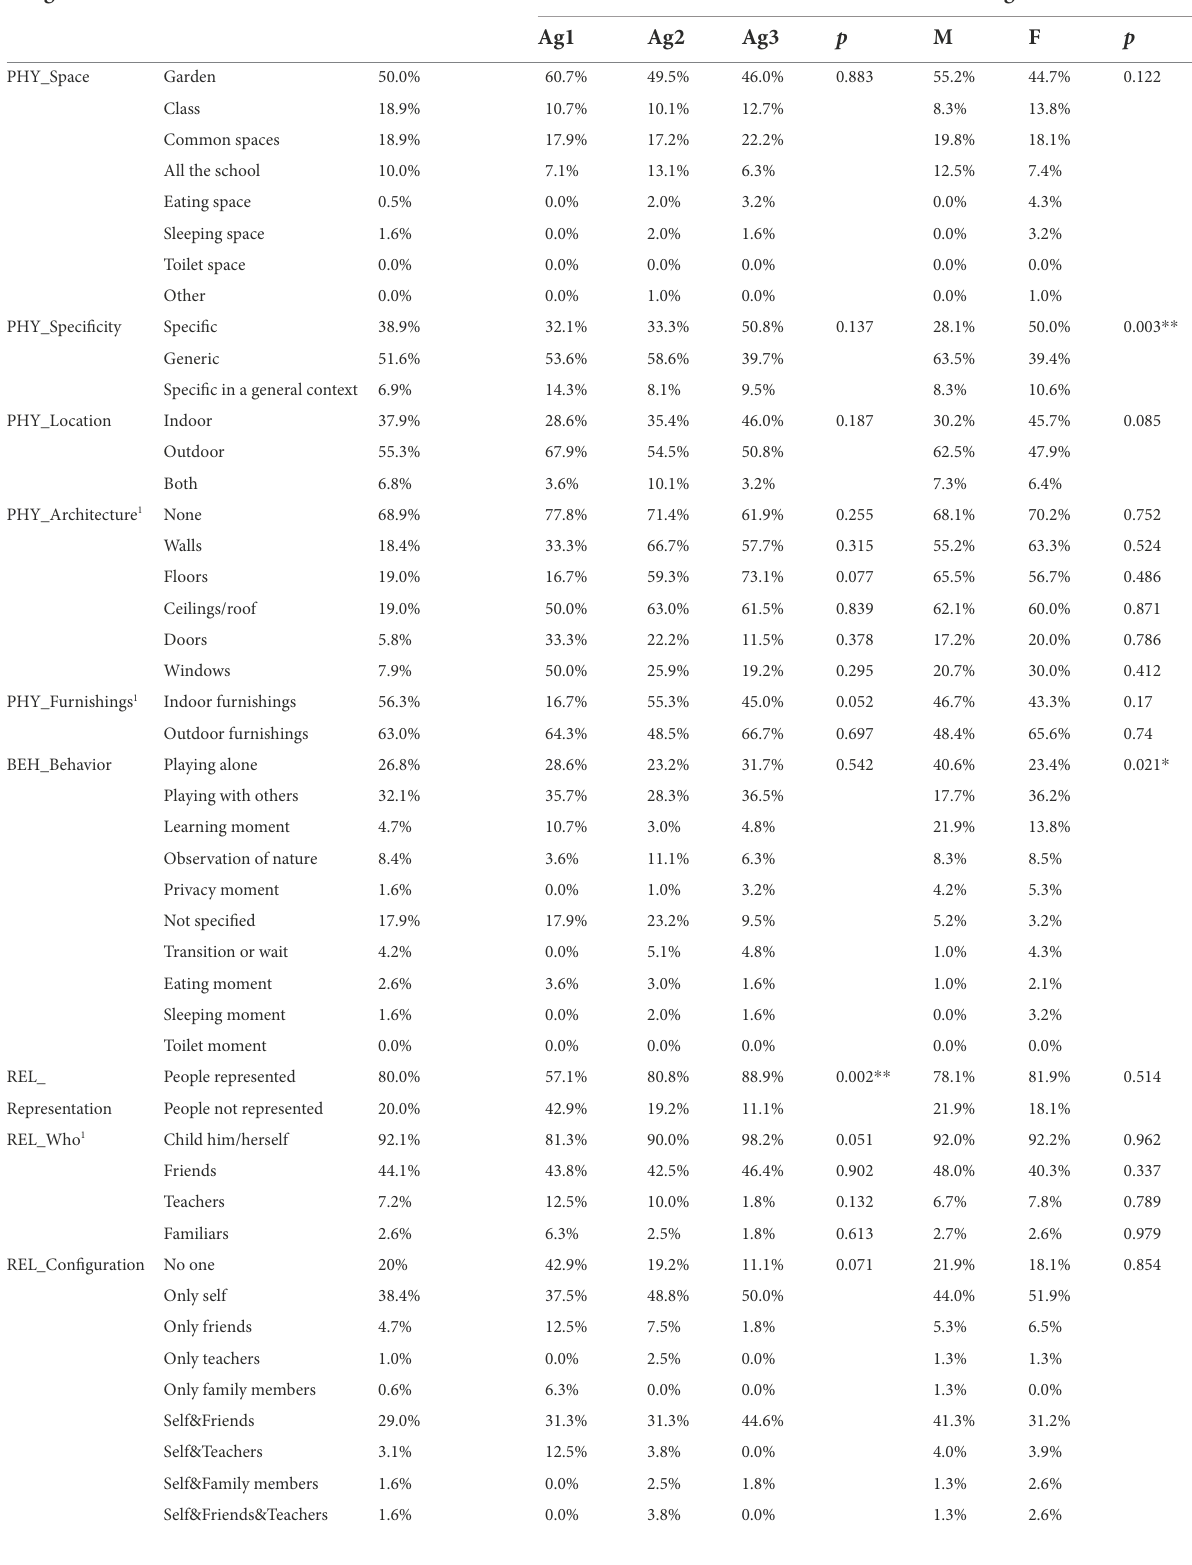
TABLE 7 Distribution of frequencies and Chi-square test for Age and Gender for each category of the first administration of the DRAW.IN.G. Macro- Categories Frequencies and Chi-square test for age Frequencies and Chi-square categories